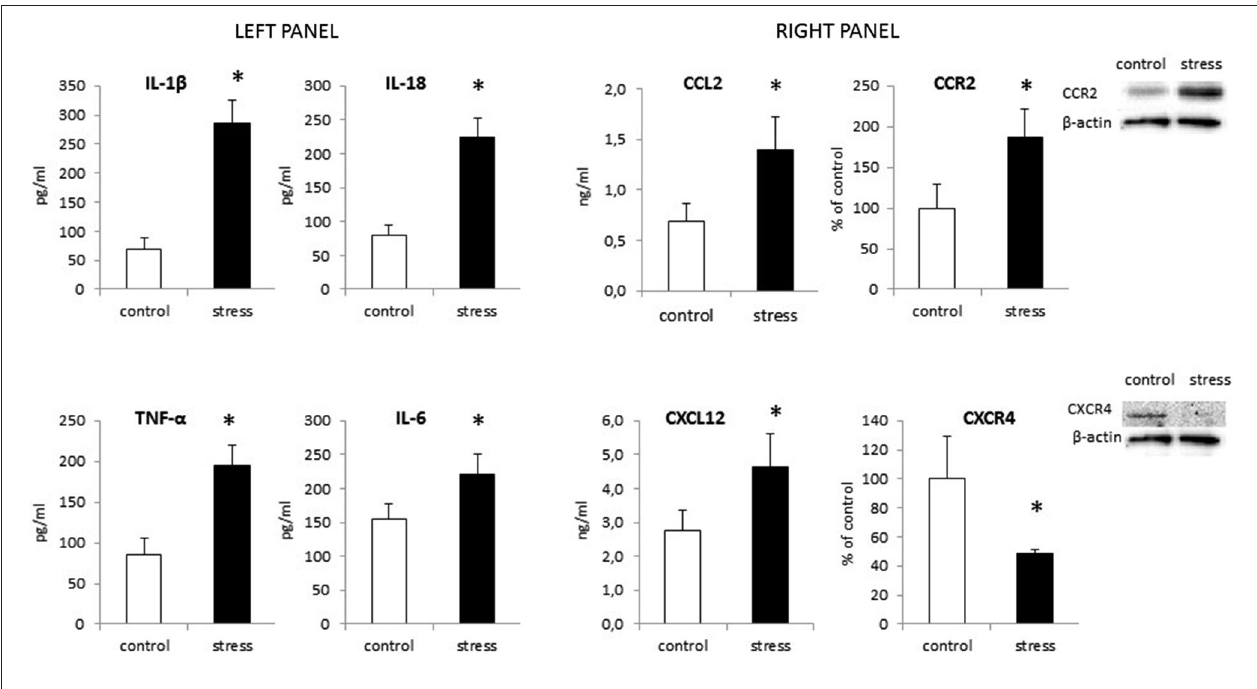
ng/ml ± SD from 3 independent experiments ( n = 8 in each group); The results from western blot analyses are normalized with β -actin and presented as % of control ± SD from 3 independent experiments ( n = 6 in each group); * p < 0.05; one-way